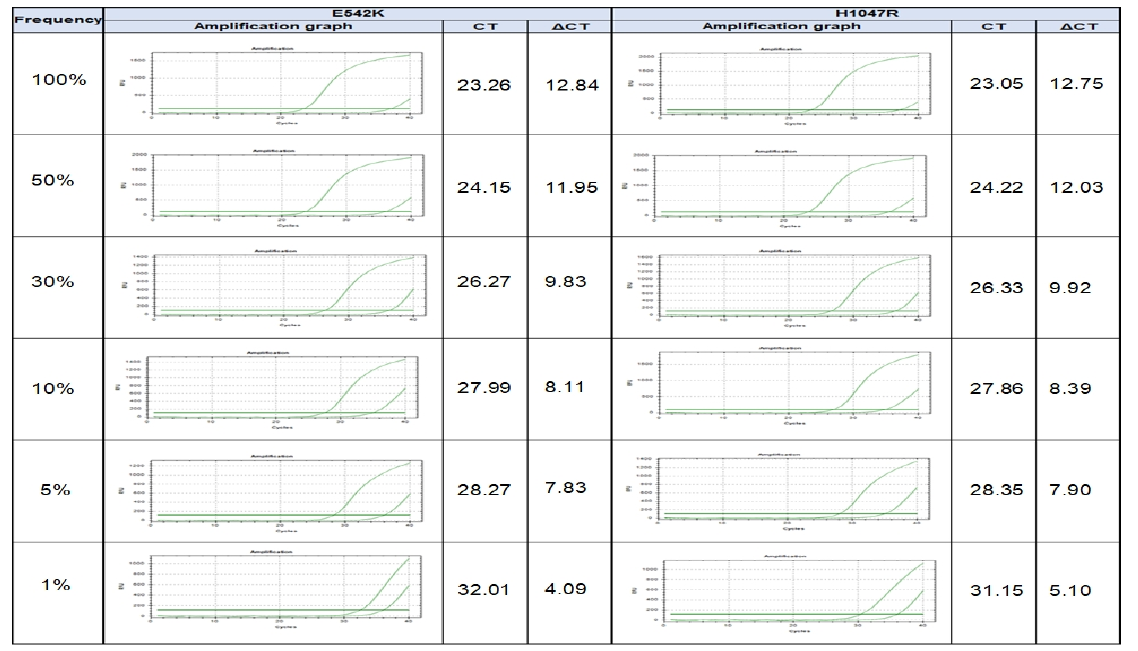
Figure 1. Validation of detection rate of PIK3CA mutation in serially diluted cell line experiment from 100, 50, 20, 10, 5, to 1% of PIK3CA -mutant